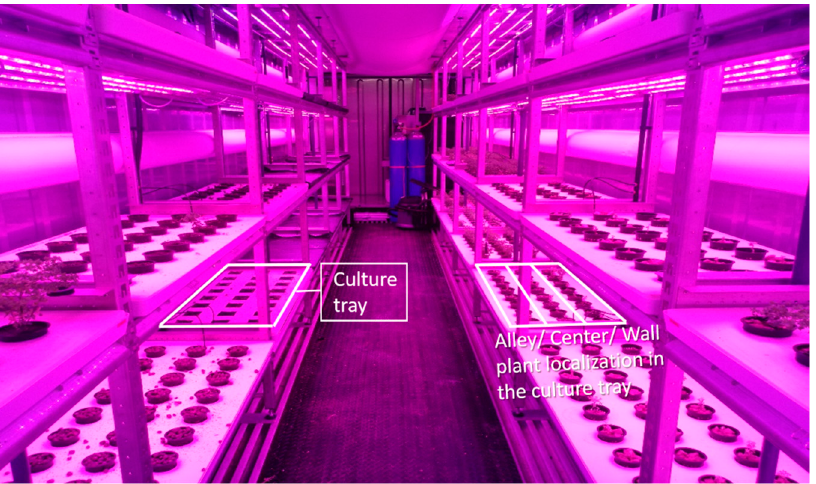
Figure 2. Cultivation area inside the modified vertical hydroponic shipping container. Thirty-six cultivation trays were placed on either side of the alley. Each cultivation tray could hold 24 plants distributed in bands of 8 plants in the cultivation tray as follows: along the wall, in the center of the tray, and along the alley.